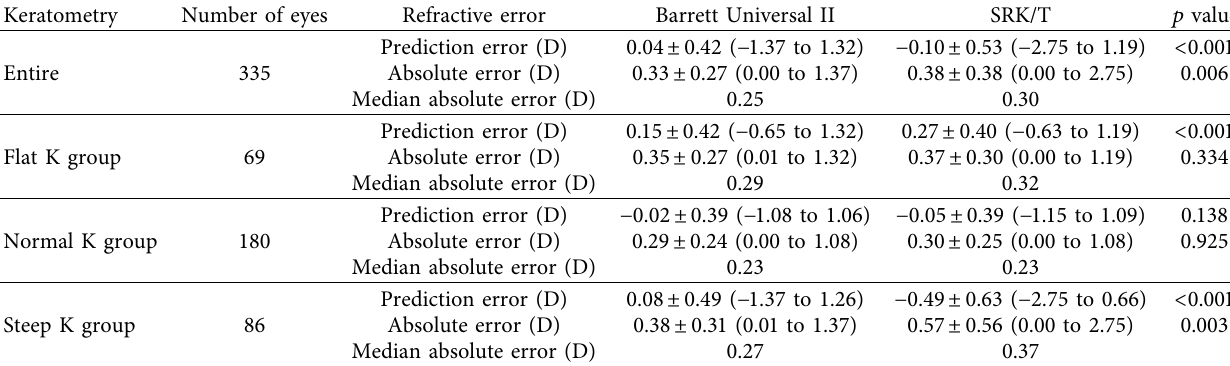
Table 2: The refractive error of the targeted refraction using the Barrett Universal II and the SRK/T formulas. Keratometry